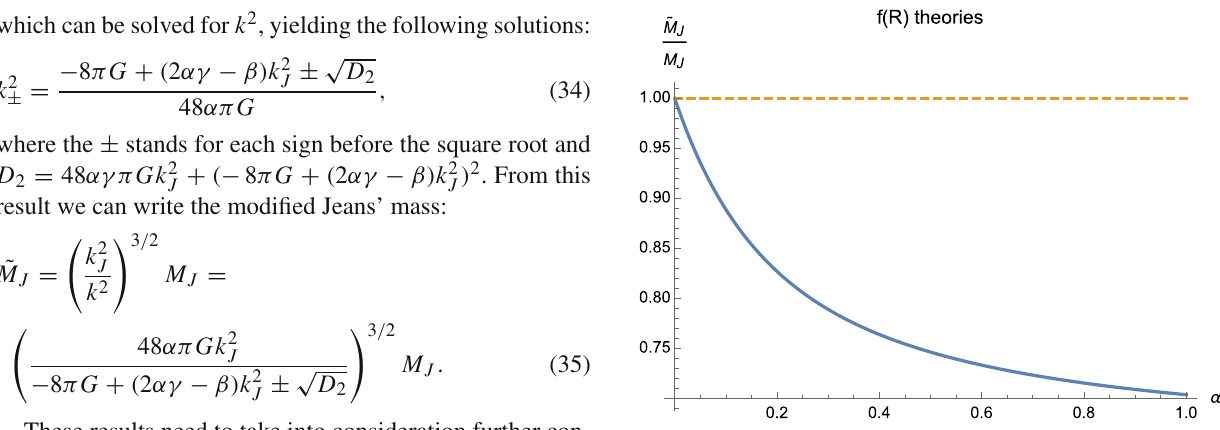
Fig. 1 Comparison between the GR (dashed line) and the f(R) theories (solid line) behaviours for the modified Jeans’